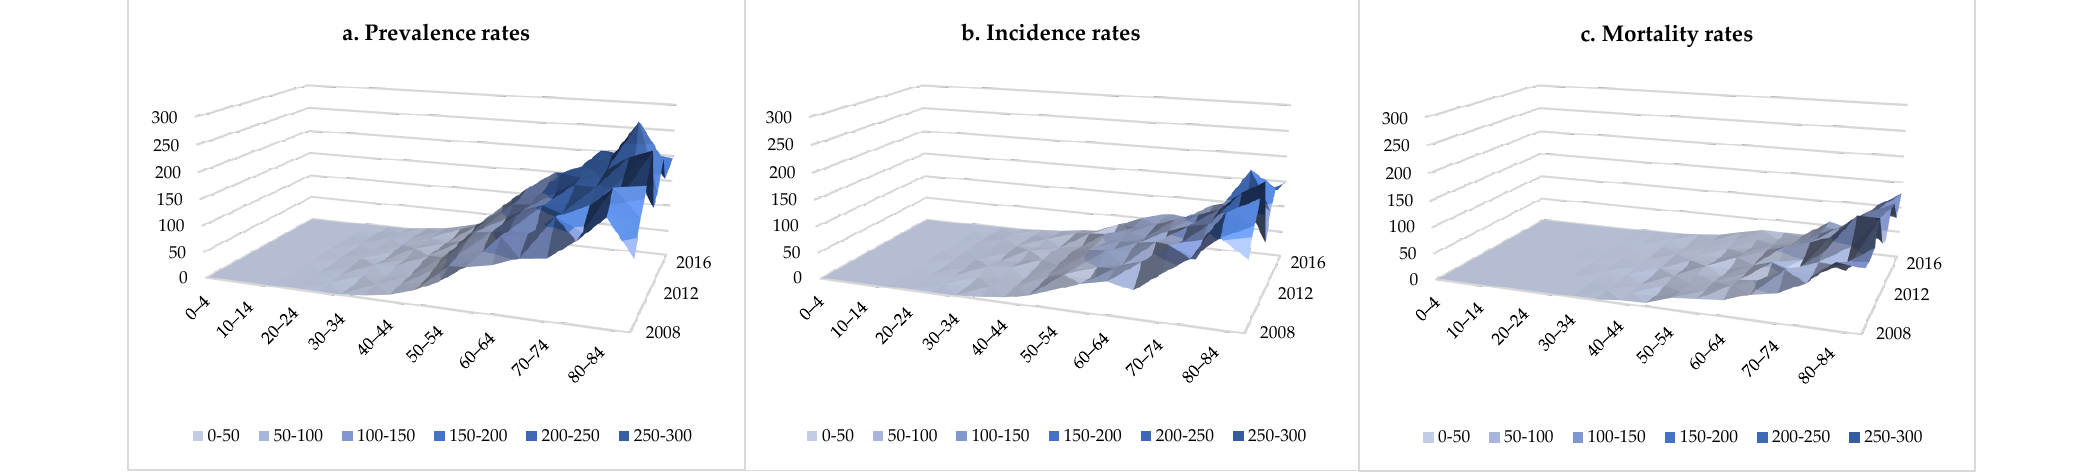
Figure 2. Age-specific prevalence, incidence, and mortality rates of HCC from 2008 to 2017.